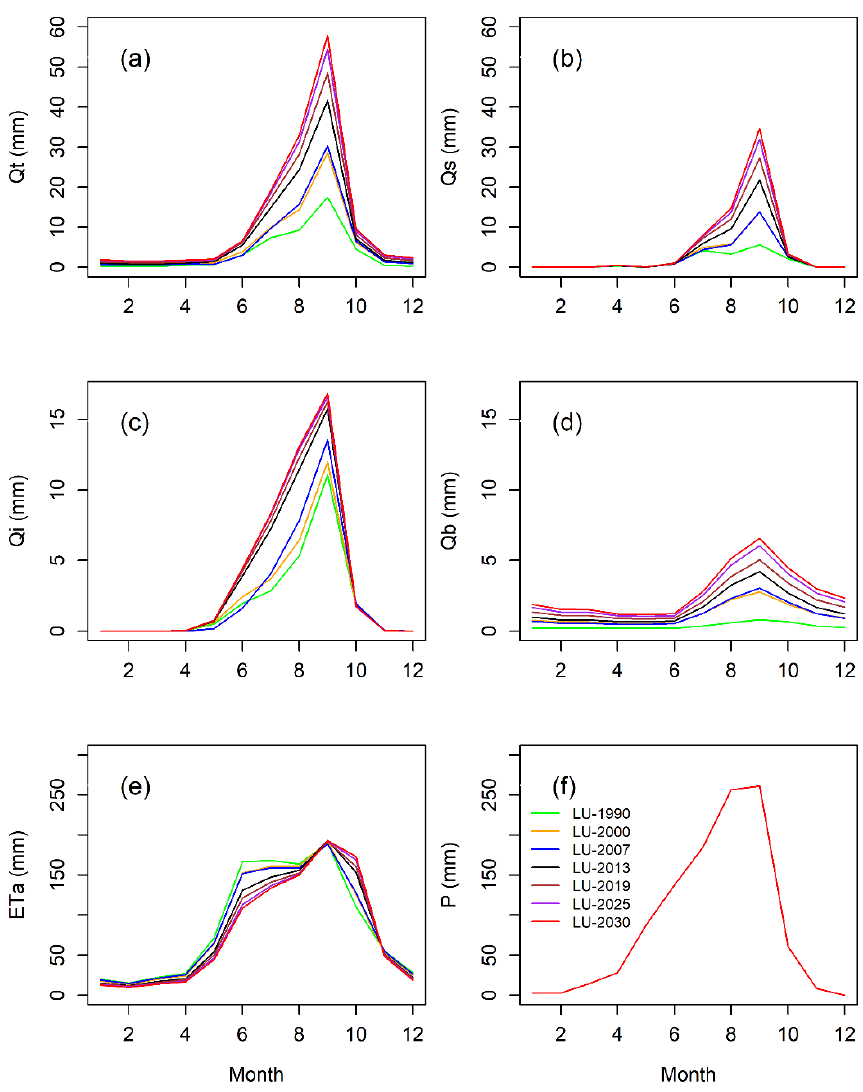
Figure 6. Mean monthly water balance variation with land use land cover change for the period of 2014–2016. Land use (LU) for the years 2019, 2025, and 2030 are modeled land use and land cover. ( a ): Total runoff (Qt); ( b ): surface runoff (Qs); ( c ): interflow (Qi); ( d ): base flow (Qb); ( e ): actual evapotranspiration (ETa); and ( f ): rainfall (P). The same meteorological dataset for all land use scenarios was used.